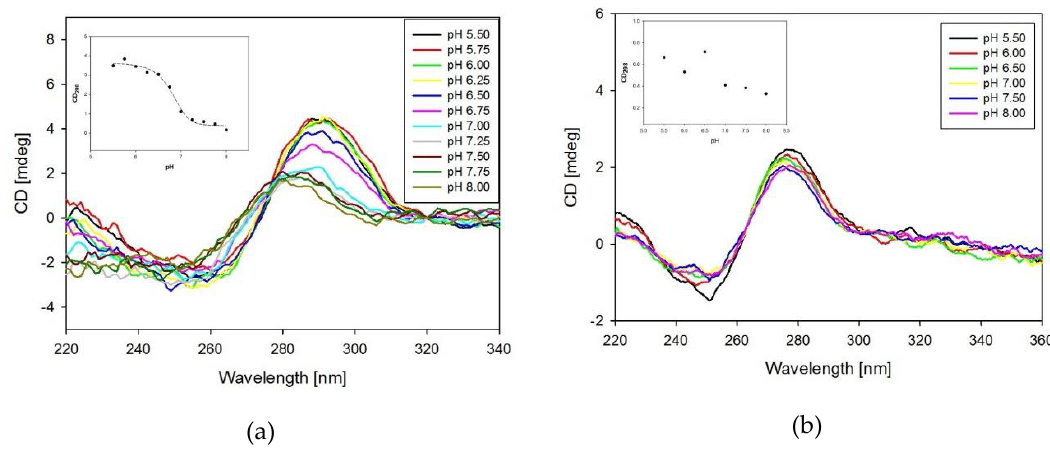
Figure 3. CD spectra of 17tC probe ( a ) and TtC probe ( b ) in the pH range of 5.50–8.00. Inserts show the dependences of CD signal at 288 nm against the pH values.